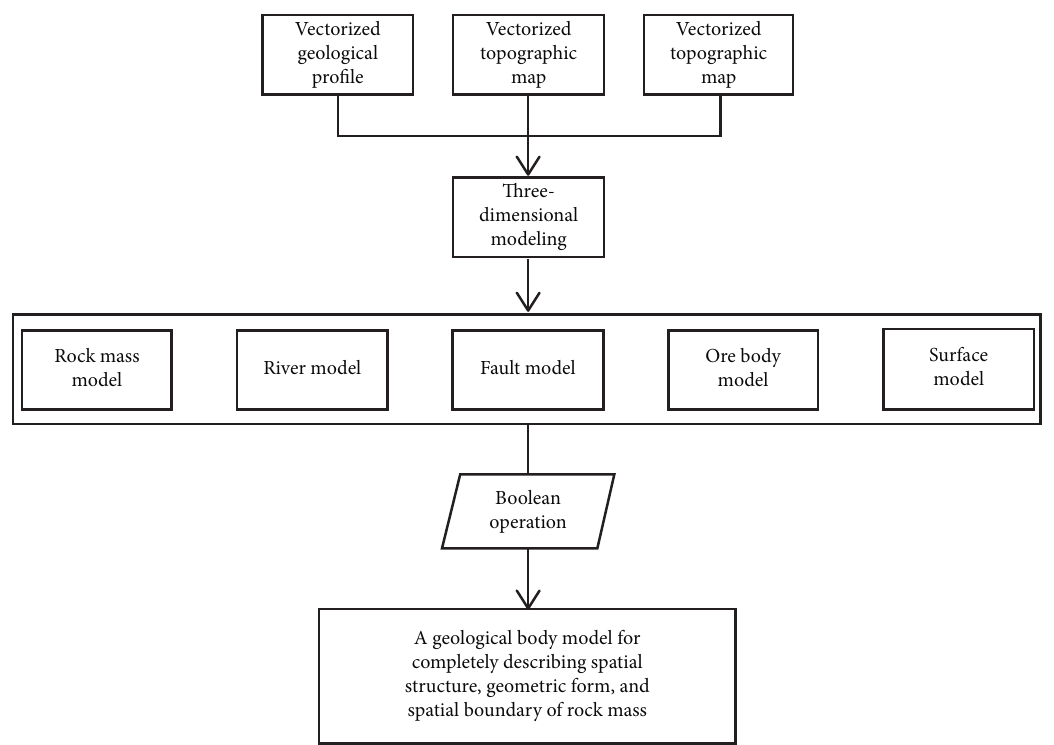
Figure 5: Flowchart of geological body